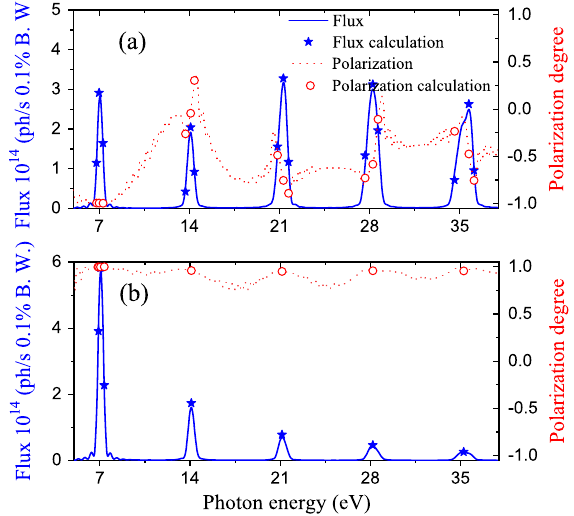
FIG. 5. The photon flux (solid blue) and polarization degree (dotted red) depend on photon energy for the linear mode (a) and the circular mode (b) in the Fig. 8 AMPU, with the pinhole radius of 0.3 mrad. The lines are from the SPECTRA code and the scatter symbols are based on Eqs. (3) and (5).